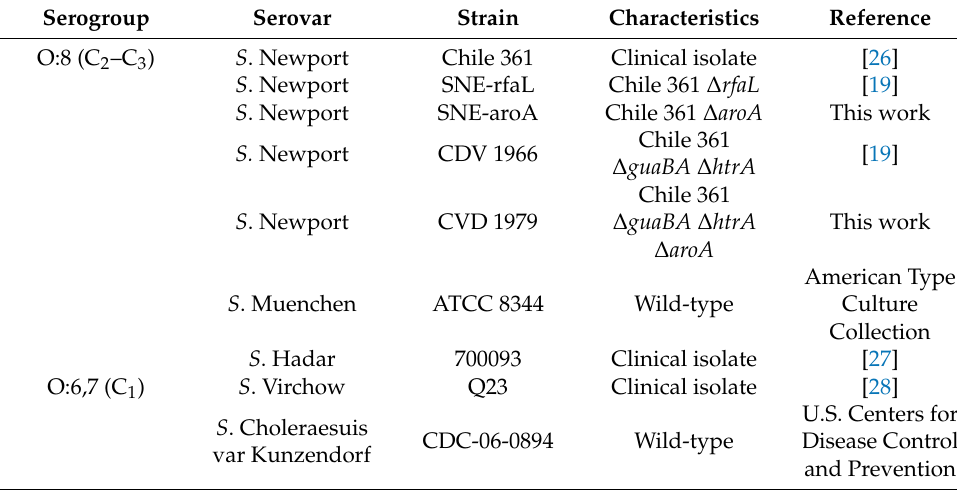
Table 1. Salmonella strains used in this study.